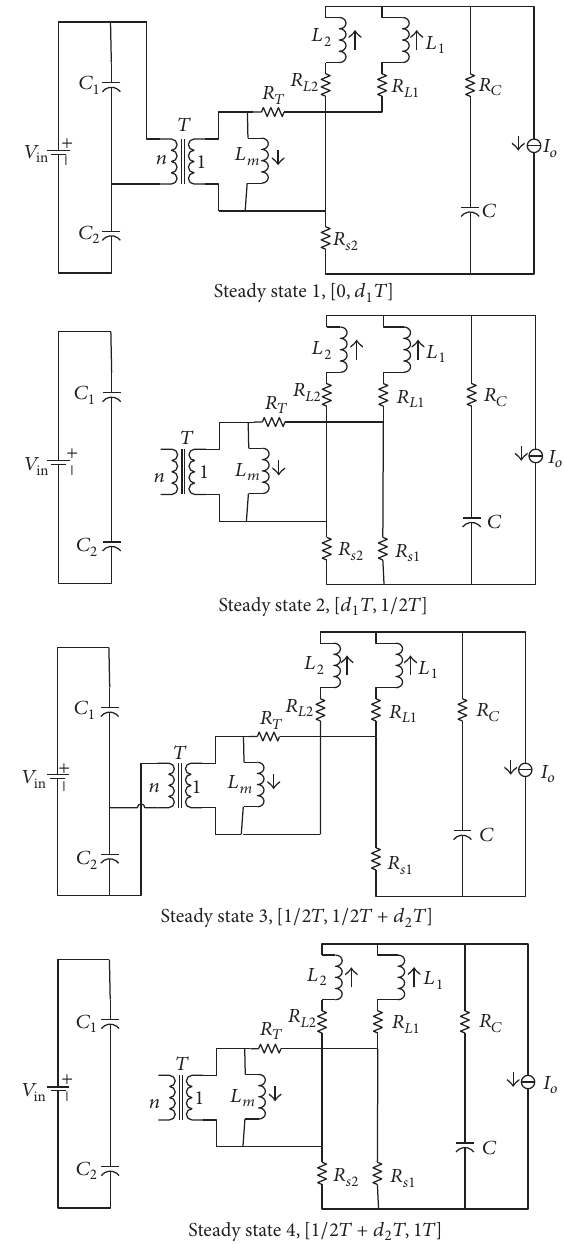
Figure 2: Working mode equivalent